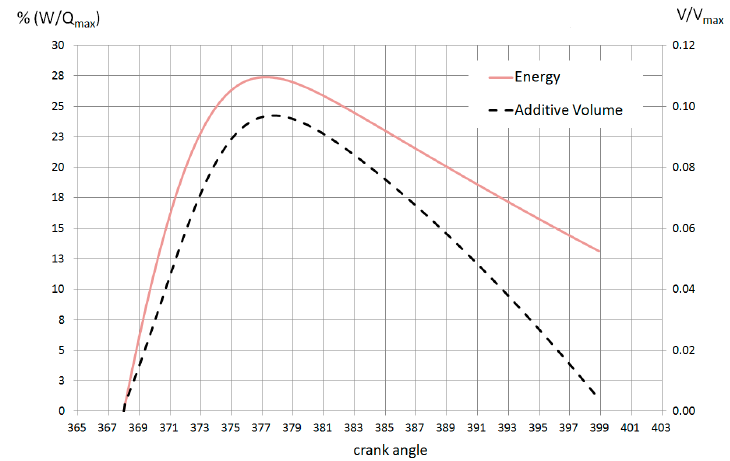
Figure 11. The flow of mechanical energy through the complementary system with respect to the relative volume in this system (1500 rpm, cr = 17:1).